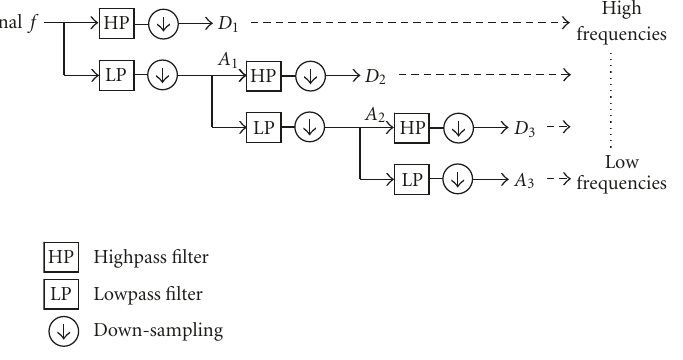
Figure 14: Fast DWT